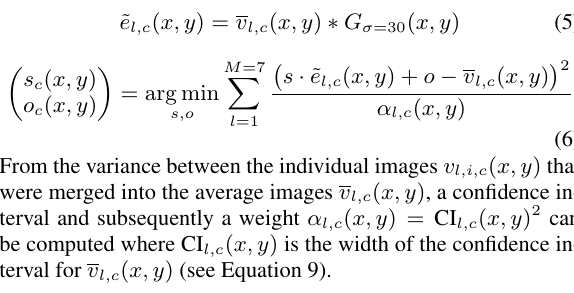
Figure 4 visualizes the scales s c ( x, y ) and offsets o c ( x, y ) per pixel x, y and color channel c as images. Several patterns are noticeable, such as the out of focus dust grains in the scale image, or the vertical stripes in the offset